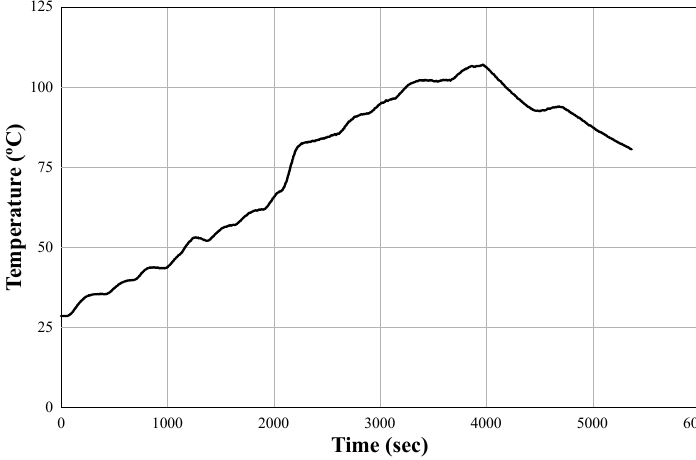
Figure 6. Chamber temperature variation.